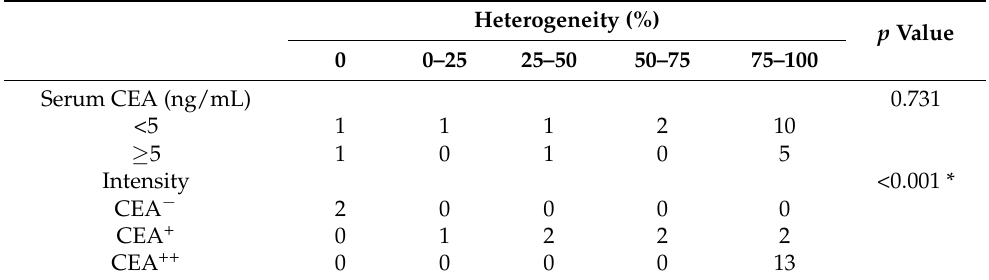
Table 2. The correlation of heterogeneity with serum CEA positivity or staining intensity of